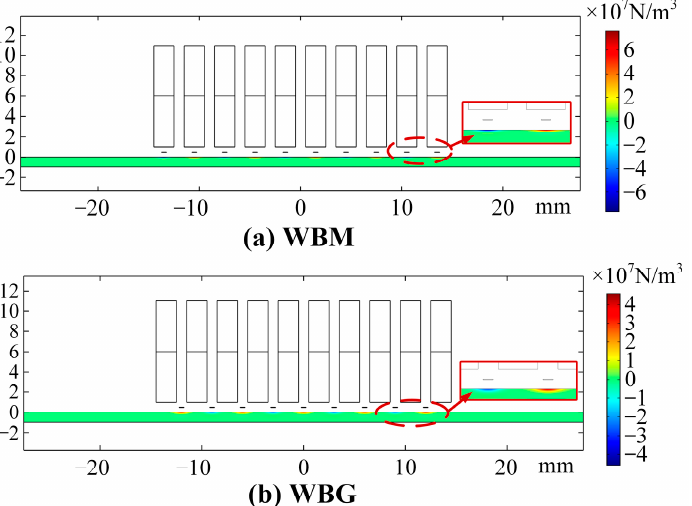
Figure 10. Lorentz force distribution. ( a ) Horizontal Lorentz force in the WBM model at 2.922 μ s and ( b ) Vertical Lorentz force in the WBG model at 10.875 μ s .